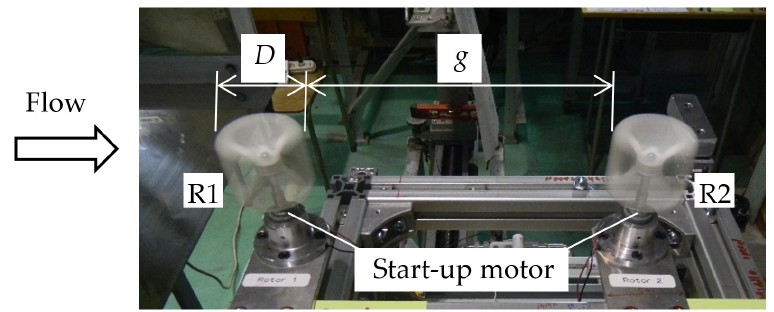
Figure 7. Setup of two VAWT models with a gap of g / D = 4 arranged in tandem.